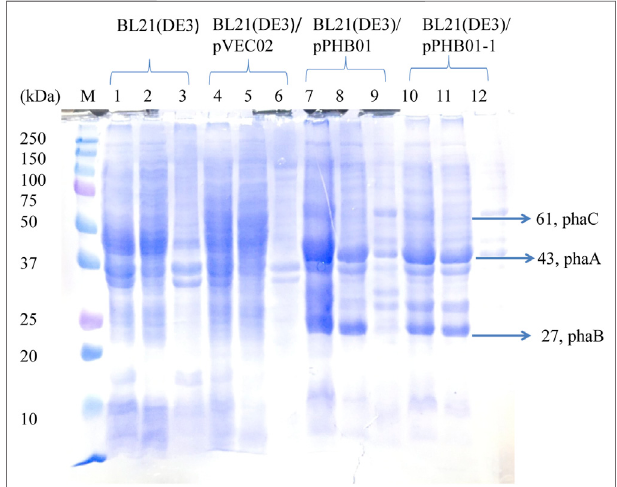
FIGURE 9 | SDS-PAGE of E. coli BL21 (DE3)/pPHB01 and BL21 (DE3)/ pPHB01-1.M:marker;lane1-lane3:BL21(DE3);lane4-lane6:BL21(DE3)/ pVEC02; lane 7- lane 9: BL21 (DE3)/pPHB01; lane 10 - lane 12: BL21 (DE3)/ pPHB0-1. Lane 1, 4, 7, 10: whole cells; lane 2, 5, 8, 11: soluble protein; lane 3, 6, 9, 12: insoluble